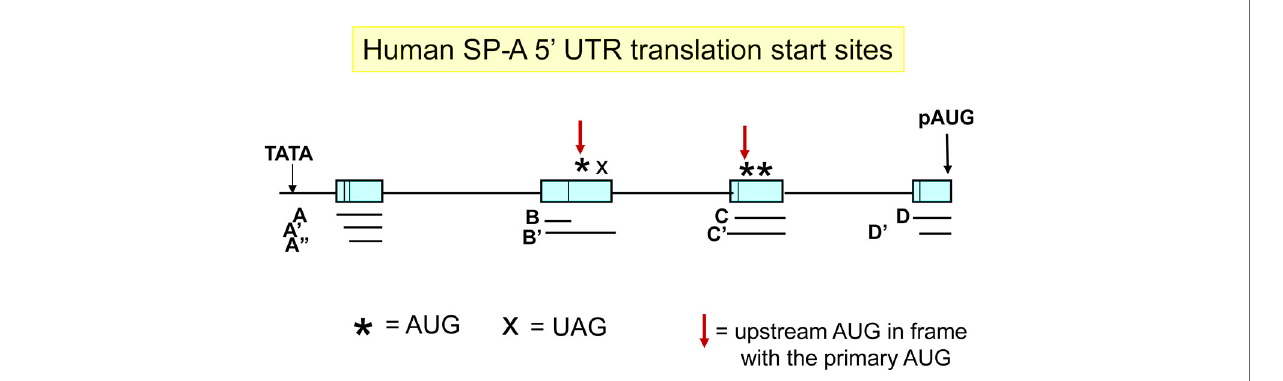
FIGURE 3 | Translation start sites at the 5 ′ -UTR. The primary translation start site (pAUG) is marked with a black arrow. Other upstream translation start sites (uAUG) in frame with the pAUG are marked with a red arrow. X denotes a stop codon in frame with the